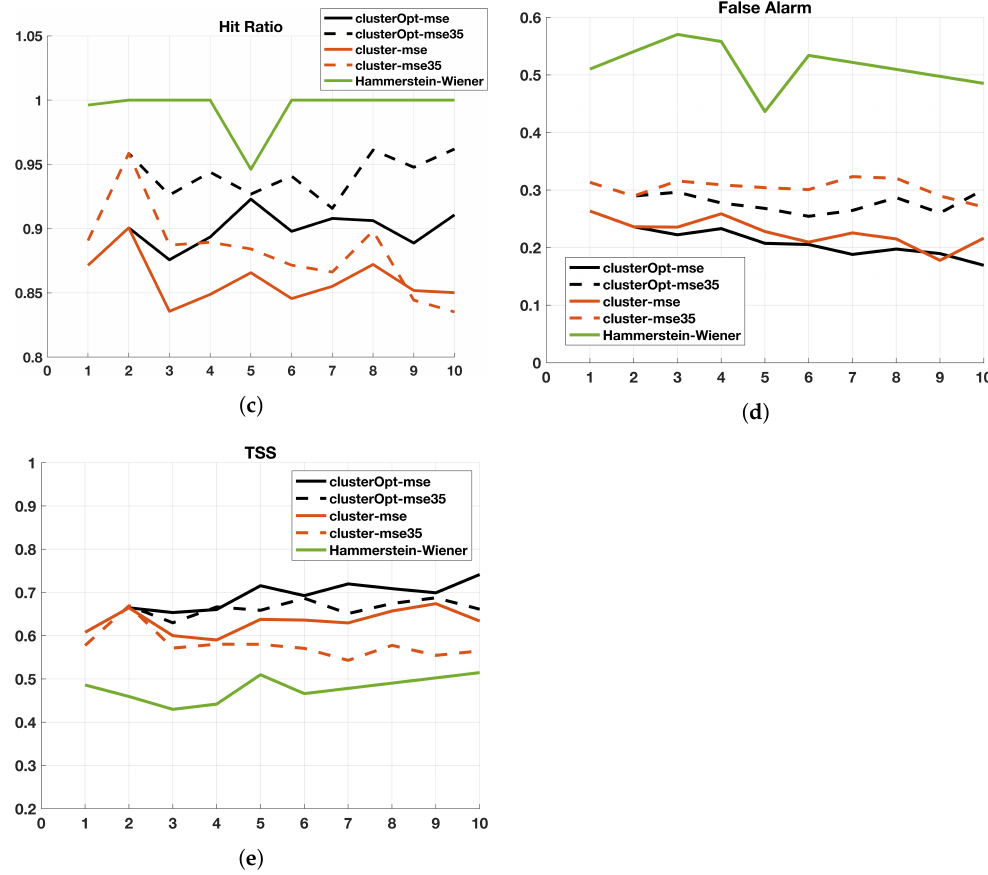
Figure 8. Index values (ordinate axis) of the 5 compared methods for K = 1 . . . 10 (abscissa axis) when n a = n l = 2. ( a ) Normalized Mean Absolute Error (NMAE); ( b ) Correlation Coefficient; ( c ) Hit Ratio; ( d ) False Alarm; ( e ) True Skill Score